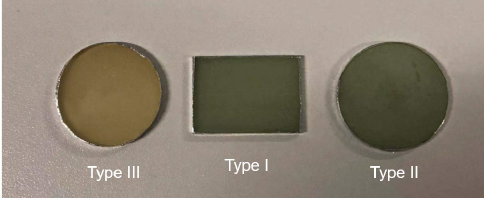
Figure 2. Surface micro morphology of the sample. ( a ) Type I and ( b ) Type II.